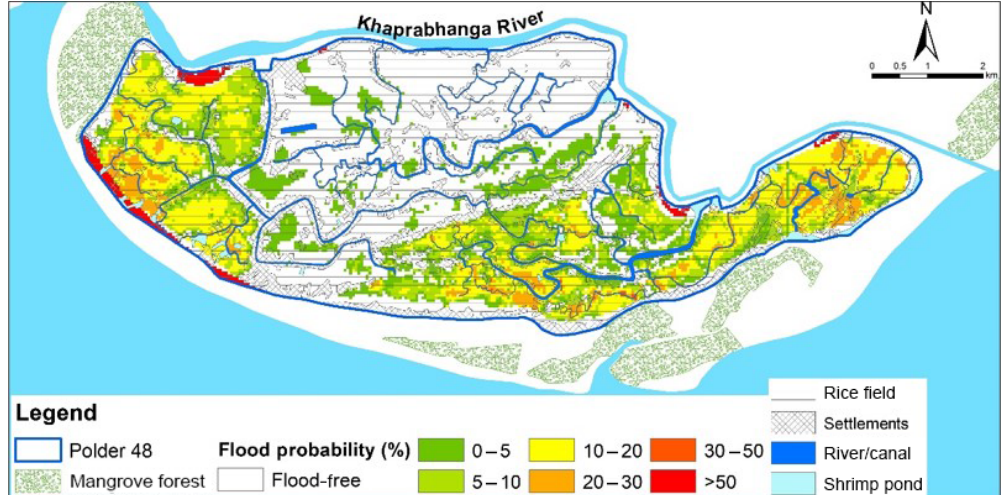
Figure 13. Probabilistic flood map of the study area. Varying colours indicate probabilities of obtaining flood depths more than